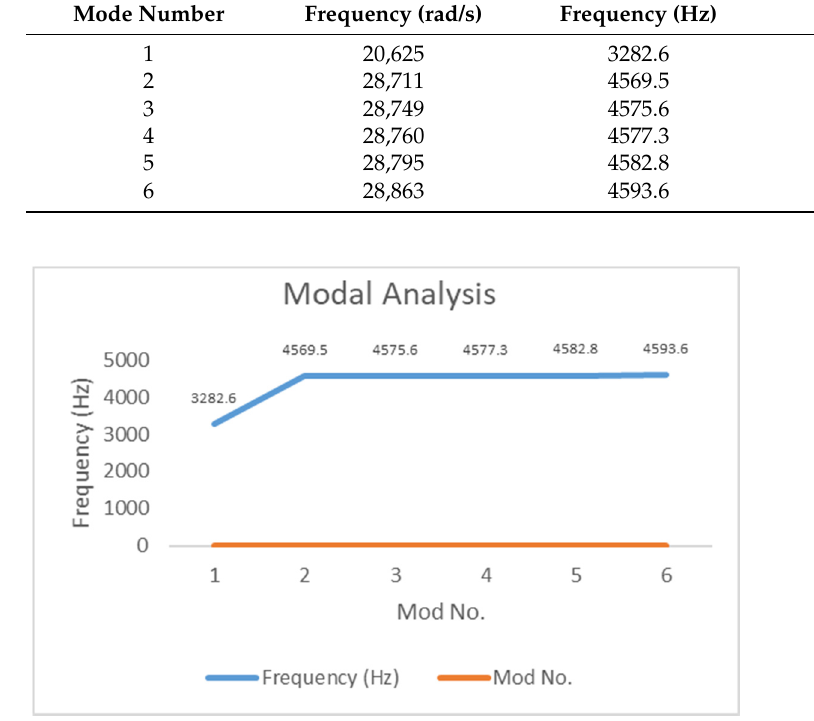
Figure 5. Natural frequency-mode graphics obtained as a result of the modal analysis.